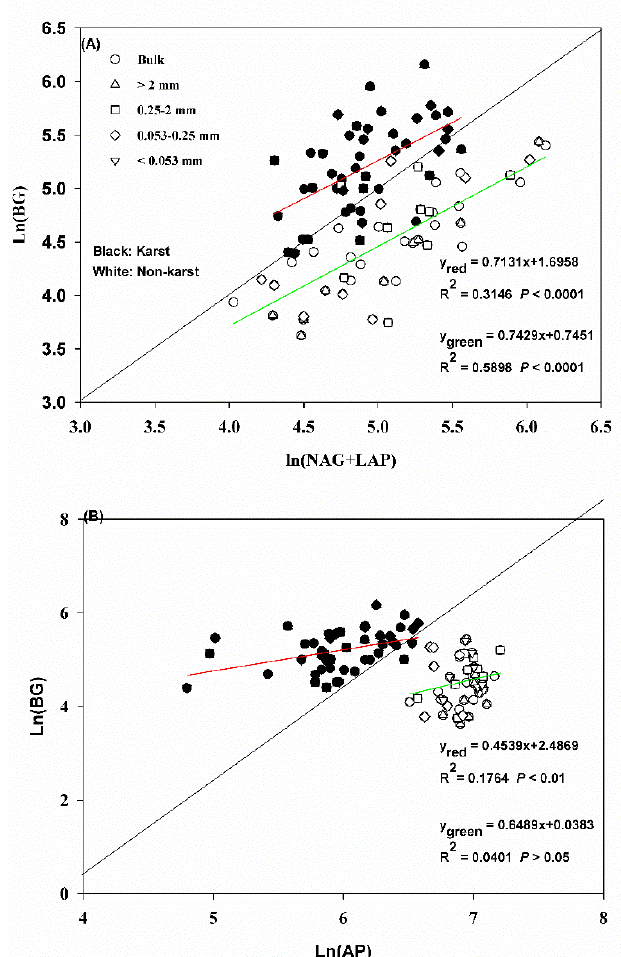
Figure 3. ( A ) C–N stoichiometric relationships in the bulk soil and aggregates in the forest ecosystems for enzymes. ( B ) C–P stoichiometric relationships in the bulk soil and aggregates in the forest ecosystems for enzymes. Black and white dots represent karst and non-karst, respectively. Error bars represent the standard deviation. Capital letters indicate differences among the forest ecosystems in the same aggregate size. Lowercase letters indicate differences in the aggregate size fractions in the same forest ecosystem.